Question: What does this figure show? Answer in one sentence.
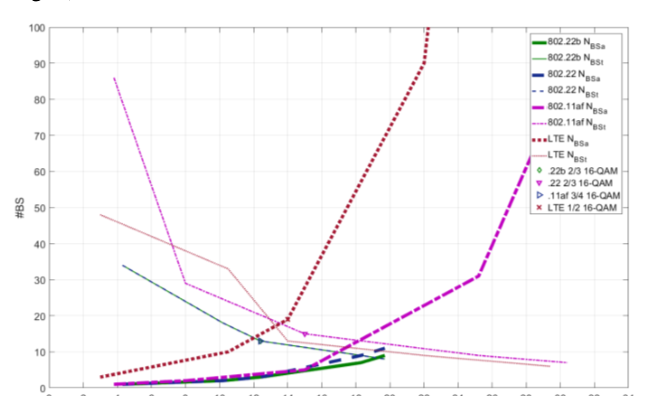
Answer: Minimum required number of BS vs required SNR in the suburban  scenario.